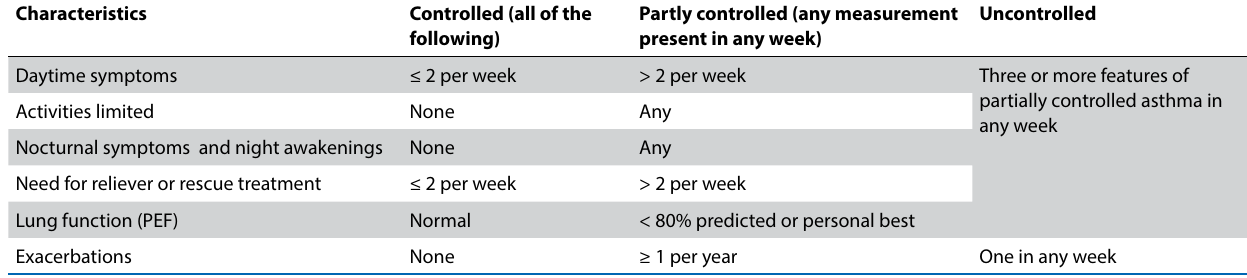
Characteristics